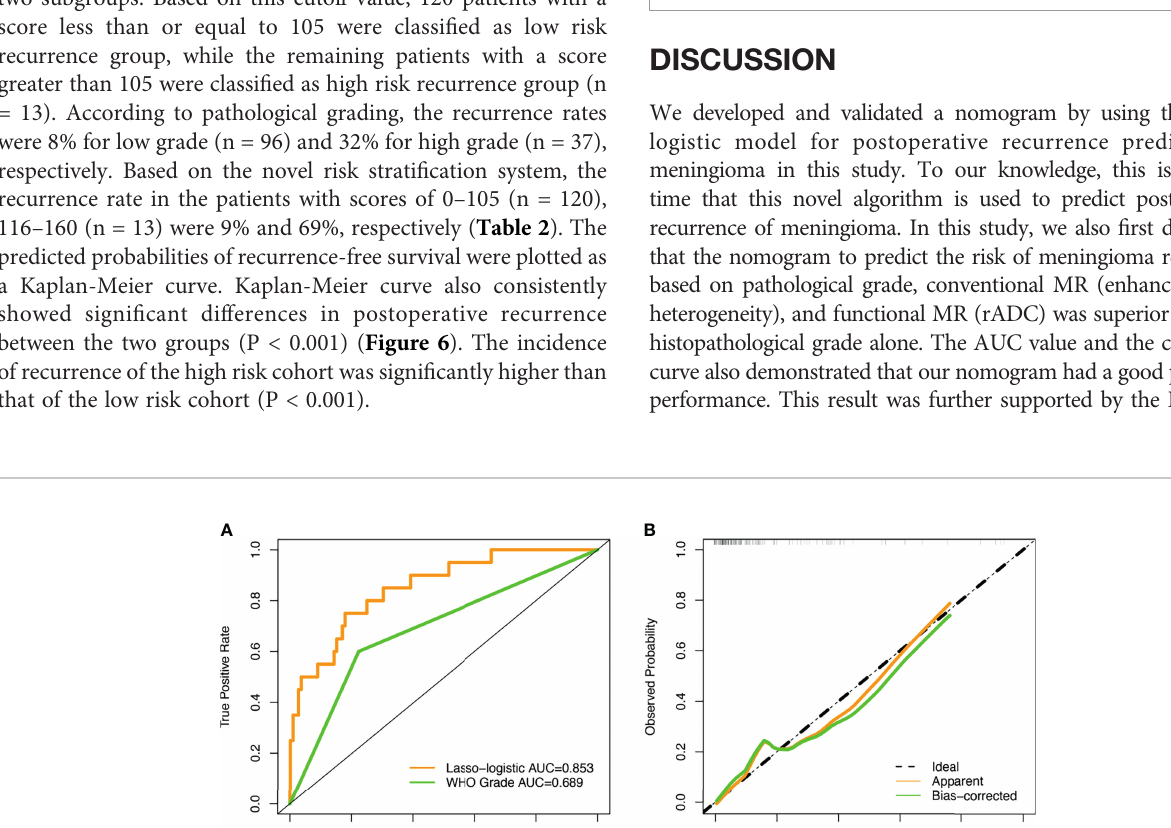
FIGURE 5 | The decision curve analysis for the novel algorithm and WHO grade. The yellow and green dotted lines represent the decision curve of the novel algorithm and WHO grade,